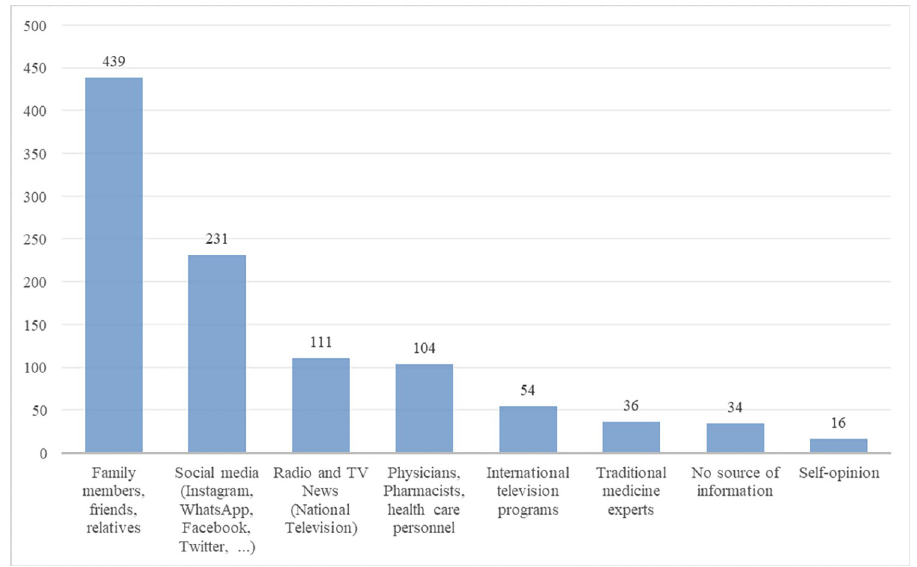
Fig 2. Primary sources of information about the COVID-19 vaccine by the number of respondents.